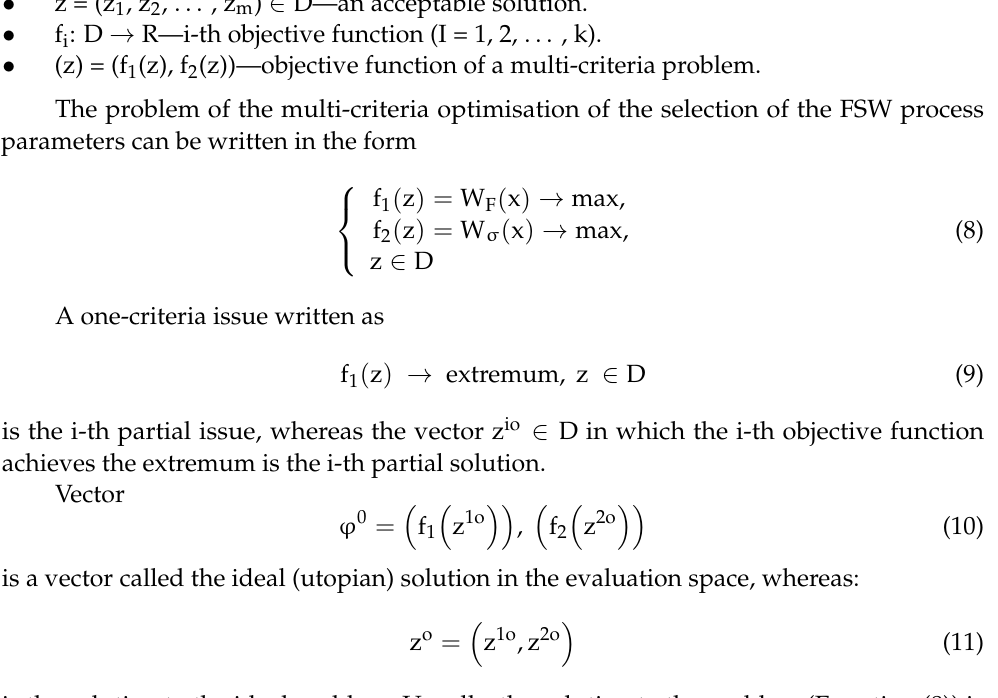
Figure 18. Plots of the regression function of ( a ) load capacity of the joint and ( b ) standard deviation of the process spread for a tool rotational speed x 2 = 1303 rpm.